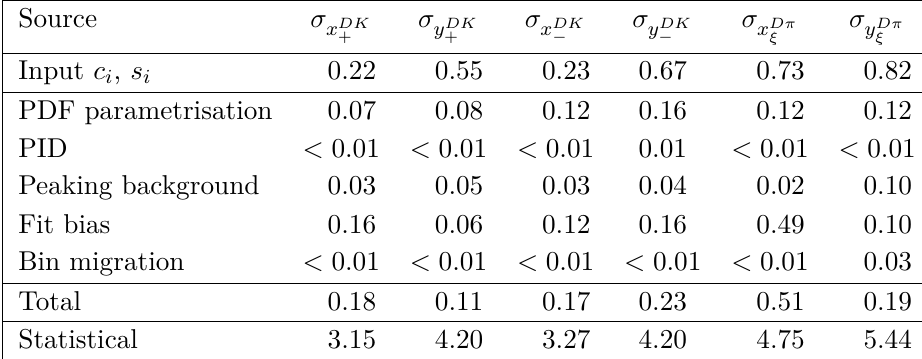
Table 3 . Systematic uncertainty summary. All values are quoted in units of 10 − 2